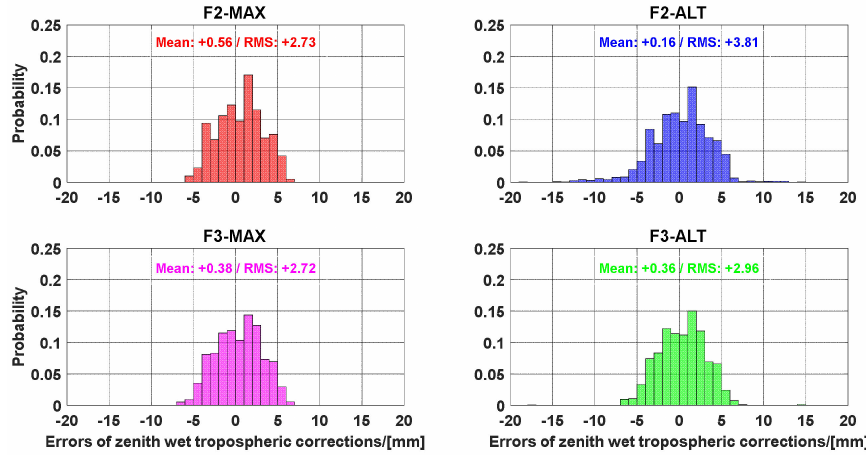
Figure 8. Error distribution of the zenith wet tropospheric corrections from WARE station.